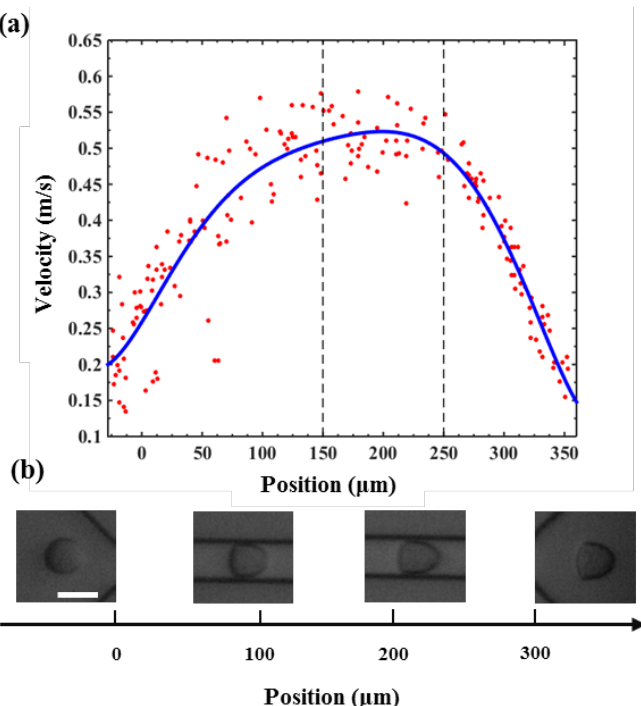
Figure 4. ( a ) The velocity distribution of a PC3 cell when flowing through the microfluidic constriction channel. ( b ) The morpho-rheological snapshots of a PC3 cell in the microfluidic constriction channel. Scale bar: 25 μm.